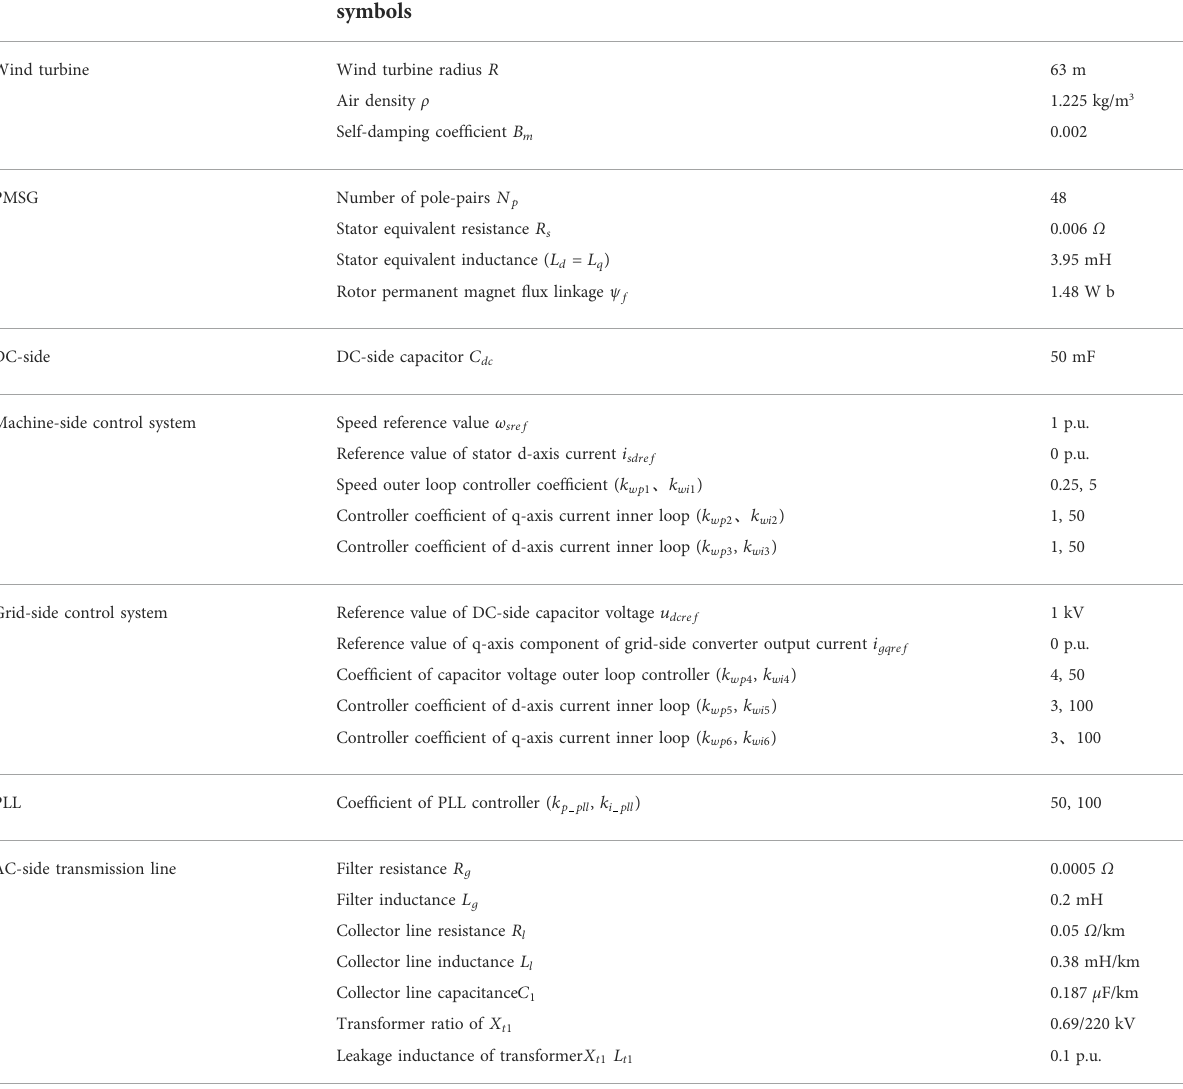
TABLE 3 Parameters of PMSG wind power